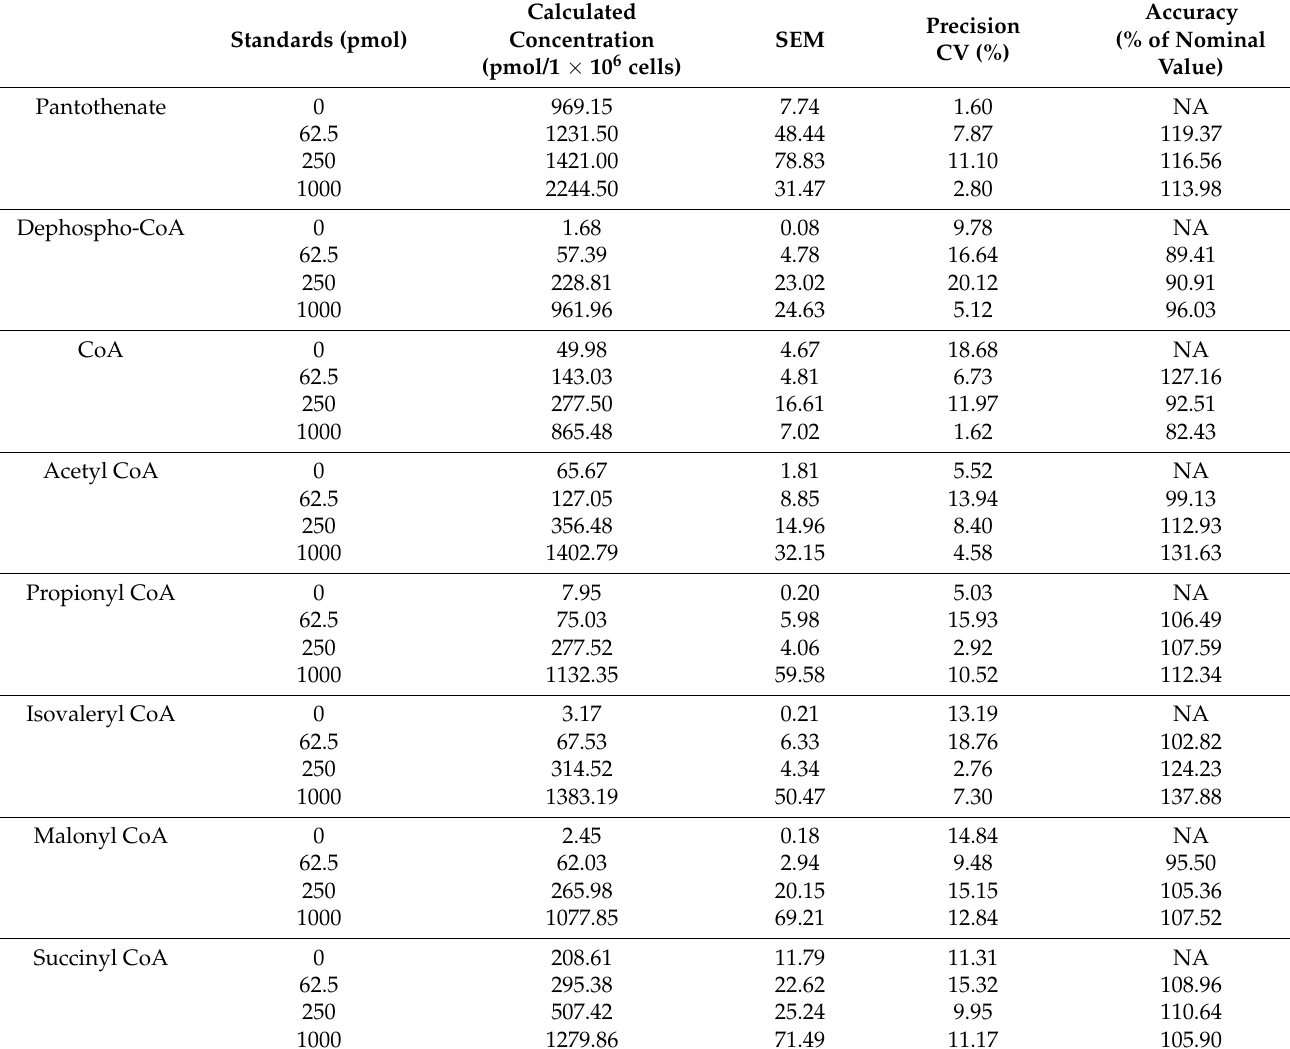
Table 4. The precision and accuracy are determined as described in the text. NA is defined as not